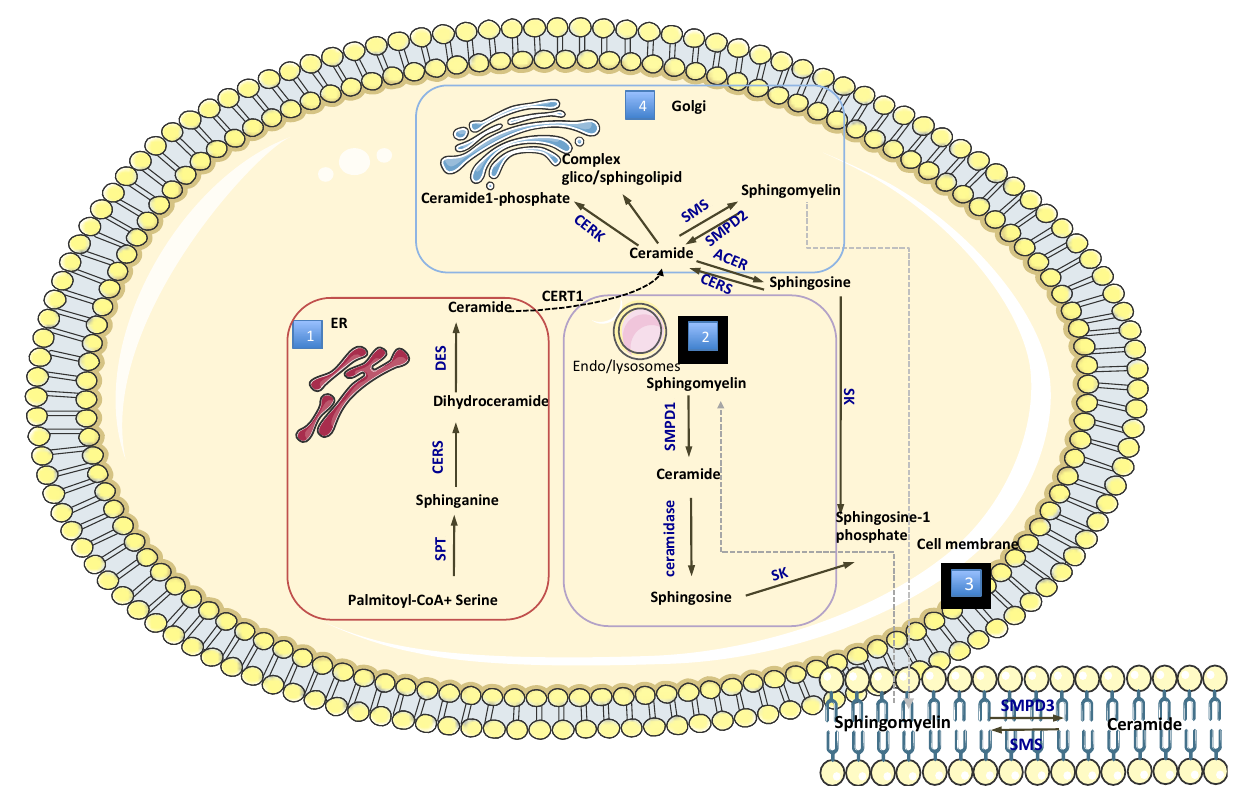
Figure 2. 1: De novo synthesis occur in endoplasmic reticulum (ER) by the activation several enzymes such as SPT: Serine Palmitoyltransferase; CERS: Ceramide synthases; DES: Dihydroceramide desaturase. 2: Salvage pathway is the synthesis of ceramide from sphingosine that occur in endo/lysosomes by the action of SMPD1: Sphingomyelinase 1 and ceramidase. 3: catabolic pathway occur on the cellular membrane by the hydrolysis of ceramides in the presence of Sphingomyelin synthases (SMS) sphingomyelin is formed, by Sphingomyelinase 3(SMPD3), ceramides is formed. 4: Transposrt and metabolism occur in Golgi apparatus. CERK: ceramide kinase; SMPD2: Sphingomyelinase2; SMS:Sphingomyelin